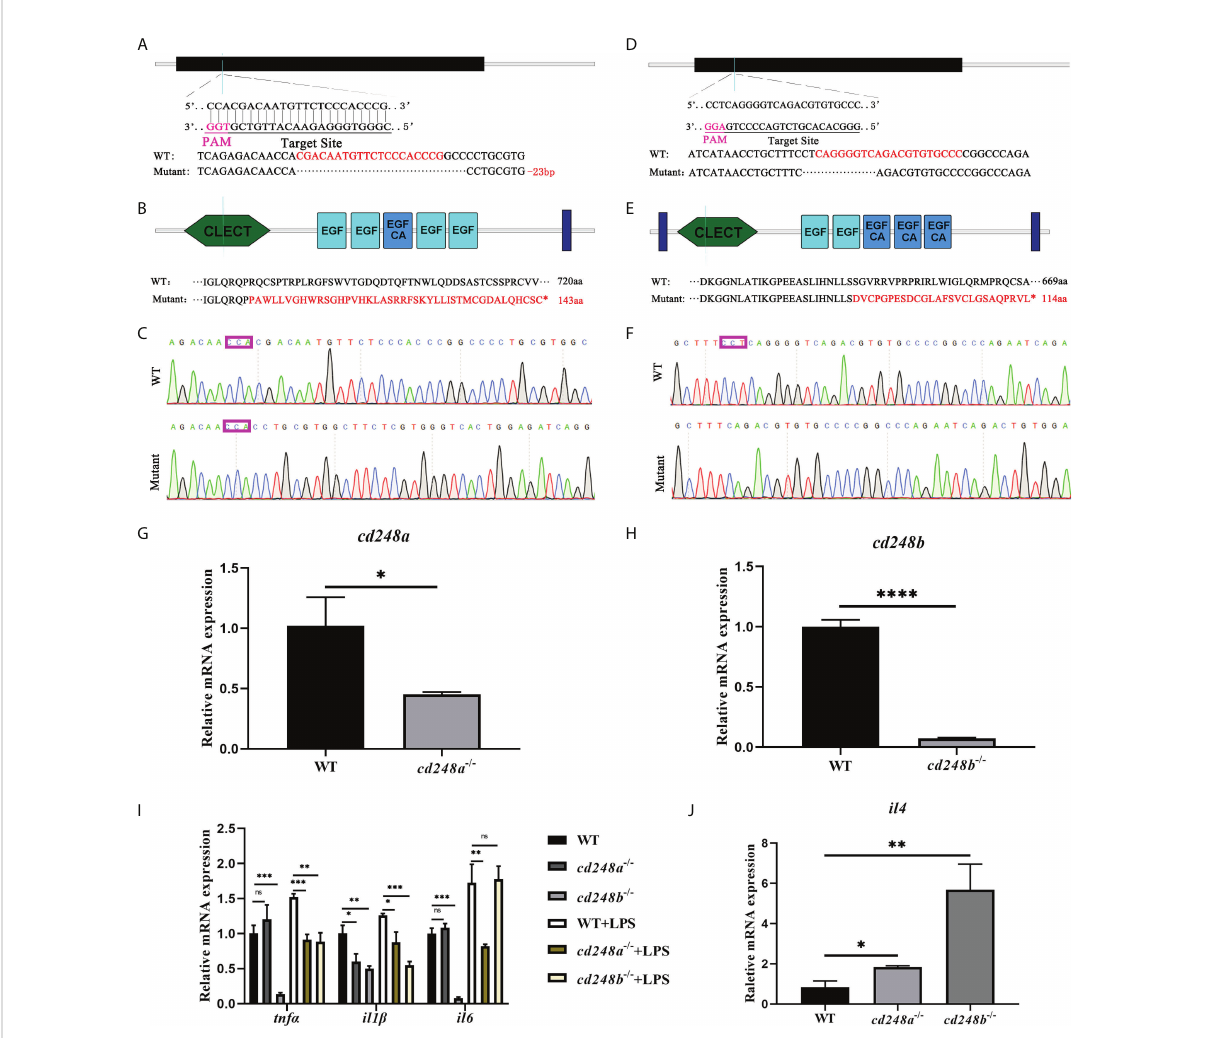
FIGURE 10 Effect of cd248 deletion on in fl ammatory cytokines. The mutants of cd248a and cd248b were carried out by CRISPR/Cas9 system. (A – C) CRISPR/Cas9 gRNA design and the genotyping result of the cd248a -mutant allele; (D – F) CRISPR/Cas9 gRNA design and the genotyping result of the cd248b -mutant allele; (G, H) Quantitative analysis of the expression of cd248a or cd248b after cd248a -deletion or cd248b -deletion compared with WT respectively; (I) Quantitative analysis of the expression of zebra fi sh tnf a , il1 b and il6 in the cd248 -mutants and LPS treatment. (J) Quantitative analysis of the expression of il4 in the cd248 -mutants compared with WT. Data were shown as mean ± SD. * P < 0.05; ** P < 0.01; *** P < 0.001; **** P < 0.0001. ns, not signi fi